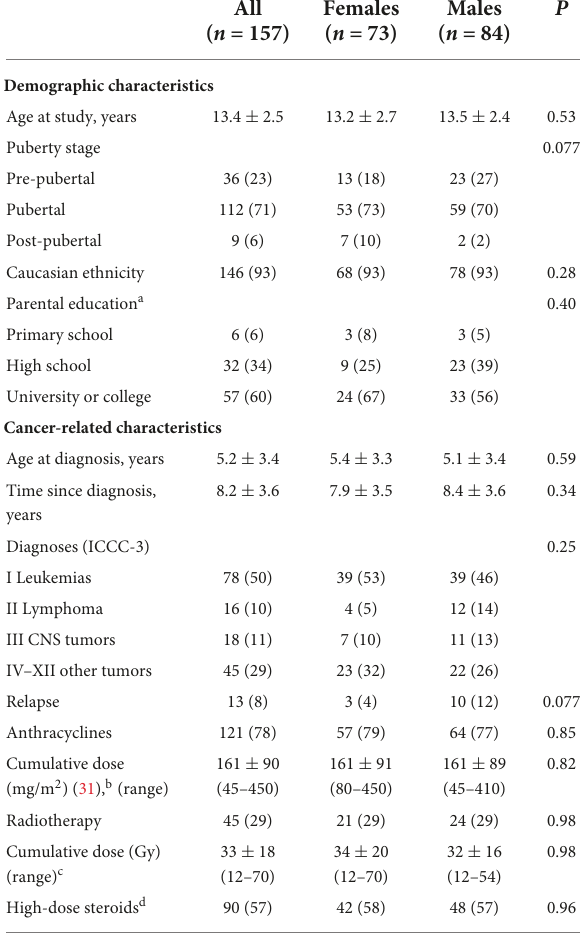
Continuousvariablesaredisplayedasmeanandstandarddeviation,categoricalvariables as frequency and proportion. There are no missing values besides the ones stated in the footnote below. CCS, childhood cancer survivors; CNS, central nervous system; CVD, cardiovascular disease; ICCC-3, International Classification of Childhood Cancer – thirdedition. a Missinginformationonparentaleducationfor62participants. b Missingcumulativeanthracyclinedosefornineparticipants. c Missingcumulativeradiationdoseforoneparticipant. d